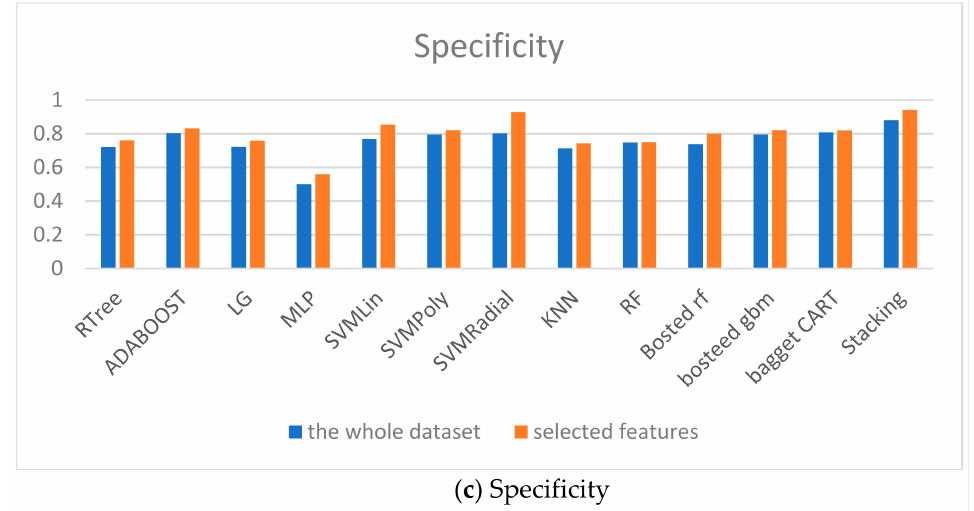
Figure 9. Models comparison.